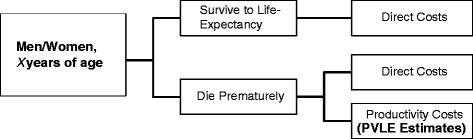
PVLE flow diagram.